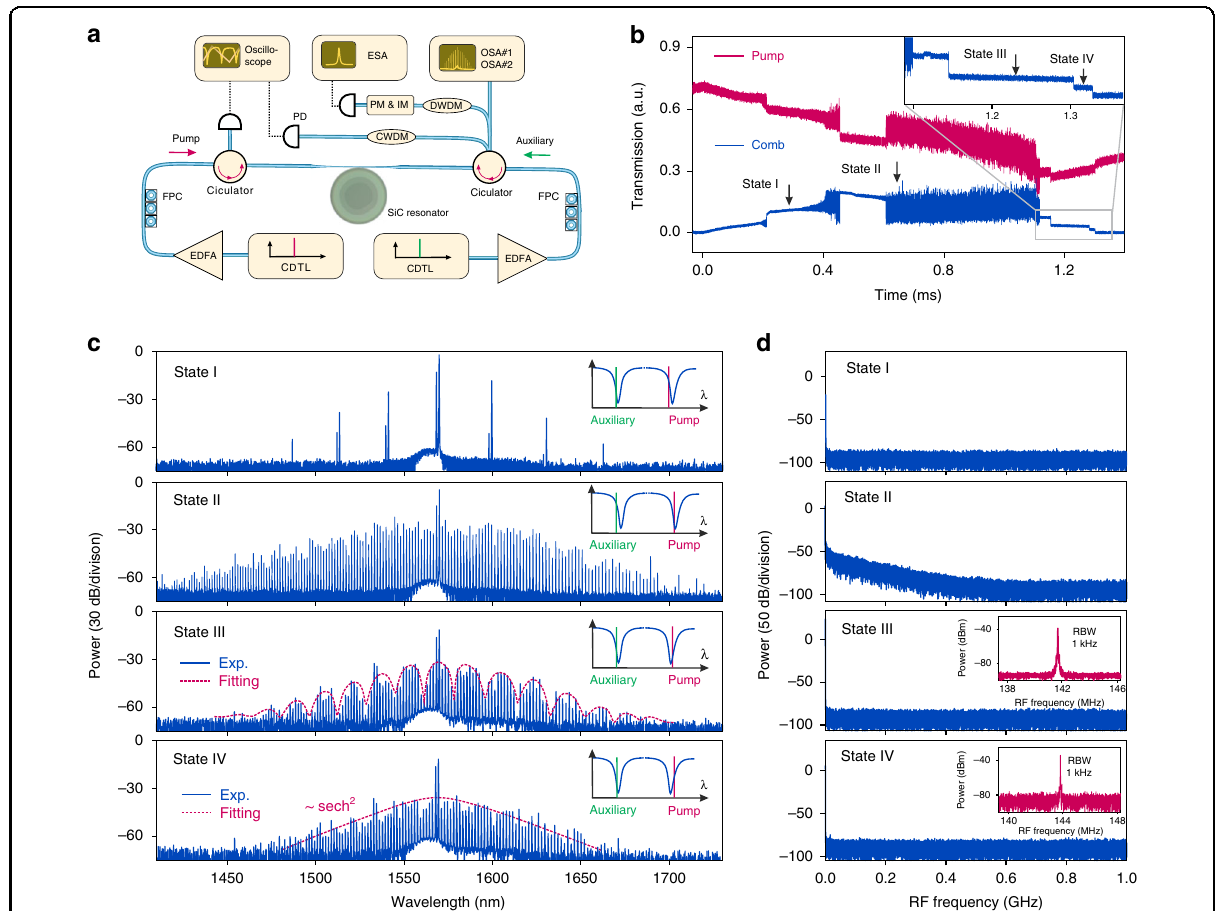
Fig. 3 Soliton formation in the 4H-SiC microresonator. a Experimental setup. CDTL continuously diode tunable laser, EDFA erbium-doped fi ber ampli fi er, FPC fi ber polarization controller, PD photodetector, DWDM dense wavelength division multiplexer, CWDM coarse wavelength division multiplexer, PM phase modulator, IM intensity modulator, ESA electrical spectrum analyzer, OSA optical spectrum analyzer. b The microresonator transmission spectrum of the pump (red) and the generated comb power (blue) when the pump laser frequency is scanned from the blue-detuned to the red-detuned of the pump resonance. The step features observed in both traces signal soliton formation. c The optical power spectra recorded at four different positions marked in b . The dashed red lines in states III and IV are fi tted soliton spectral envelope. The insets illustrate the detuning positions of the pump (red) and auxiliary (green) lasers to their respective resonances. d The RF amplitude noise spectra corresponding to the four different states. The insets show the RF beatnote with limited resolution-bandwidth of 1